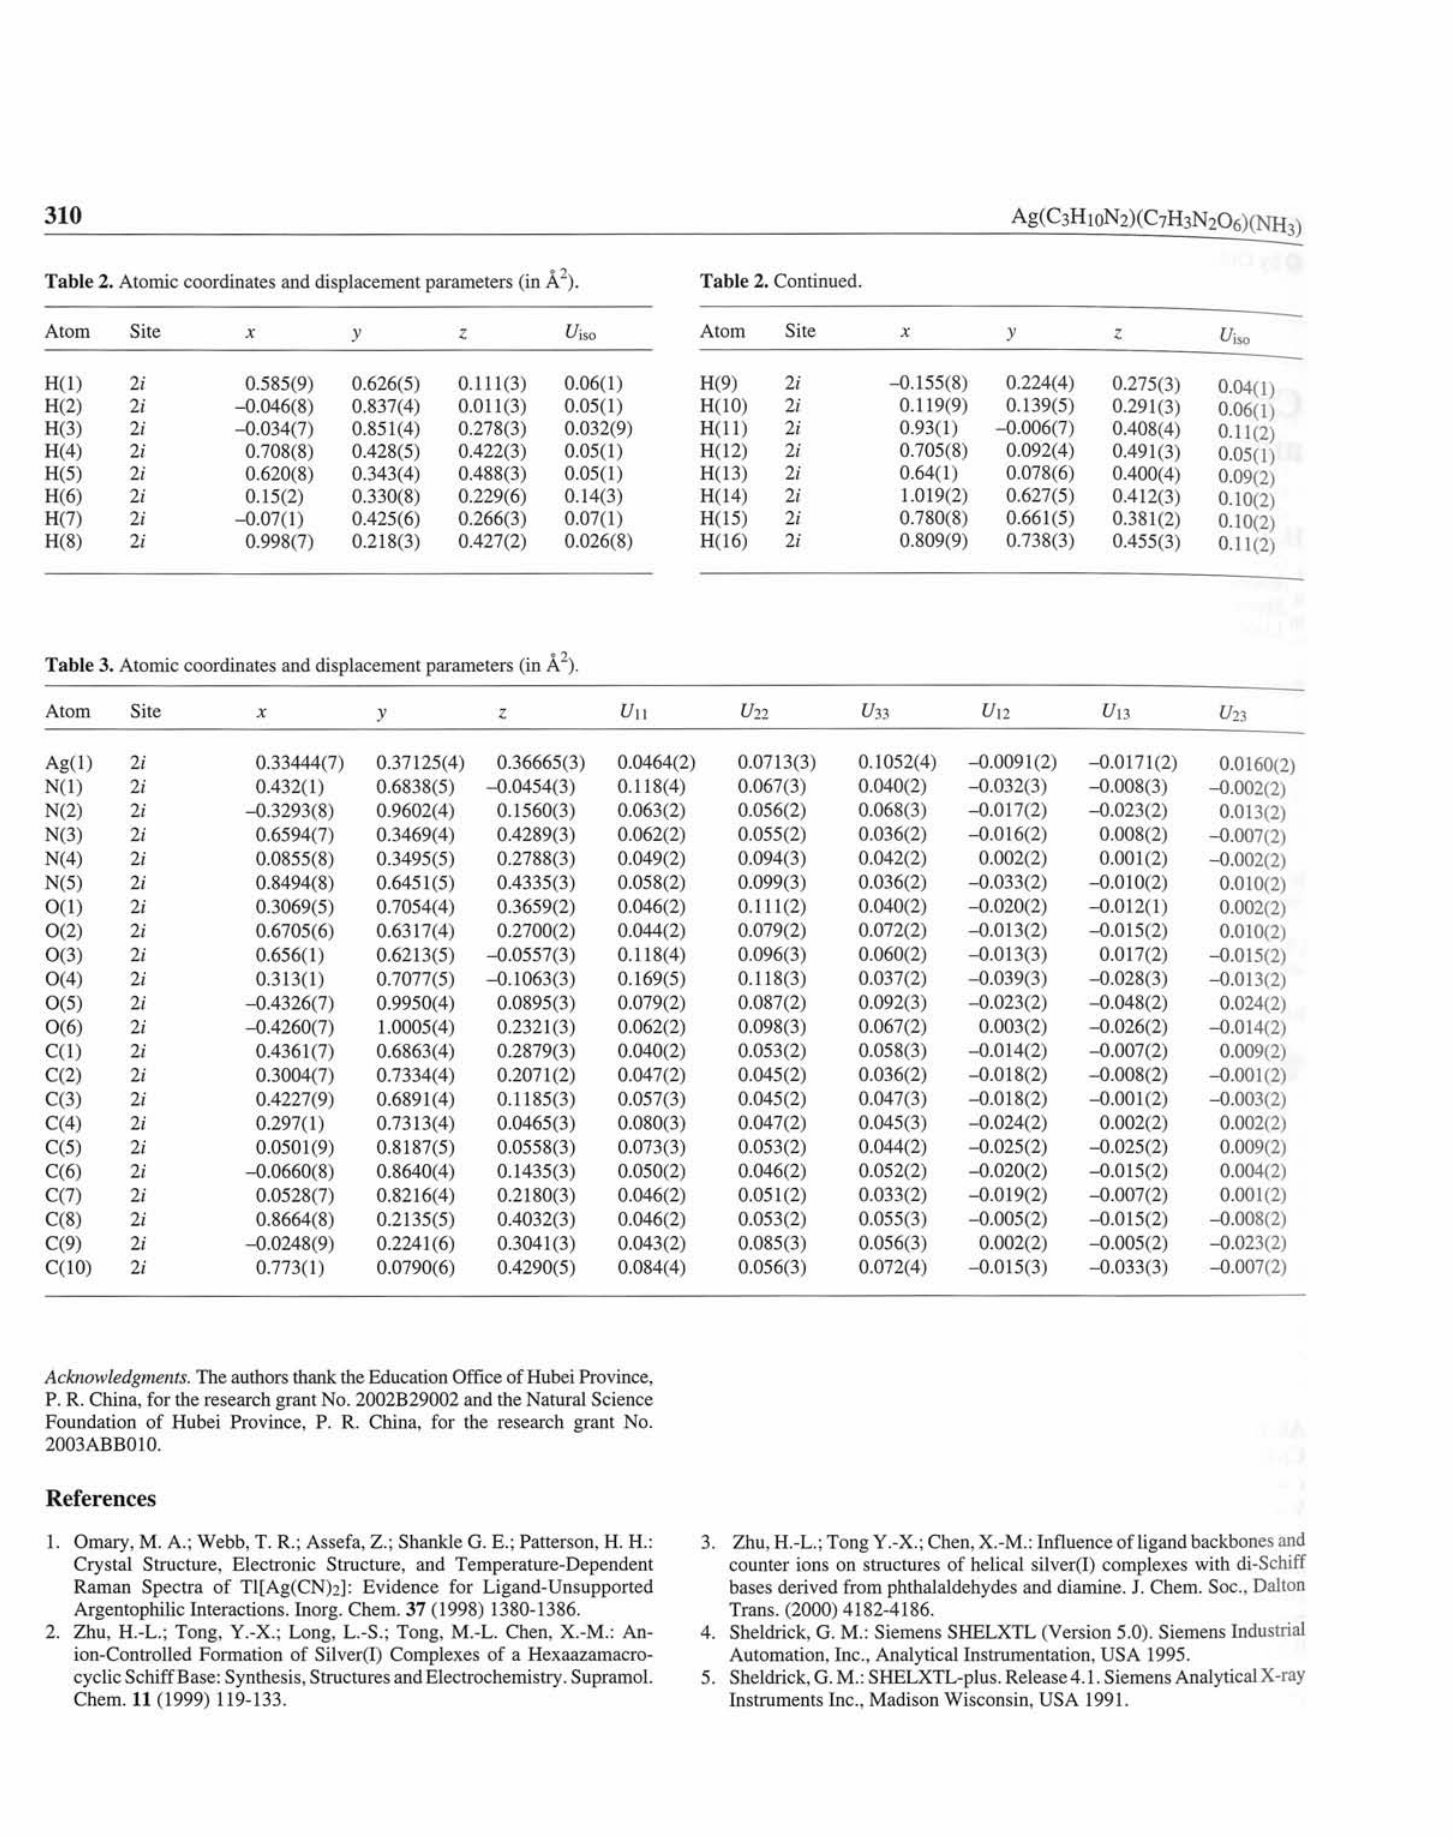
Table 3. Atomic coordinates and displacement parameters (in Â 2